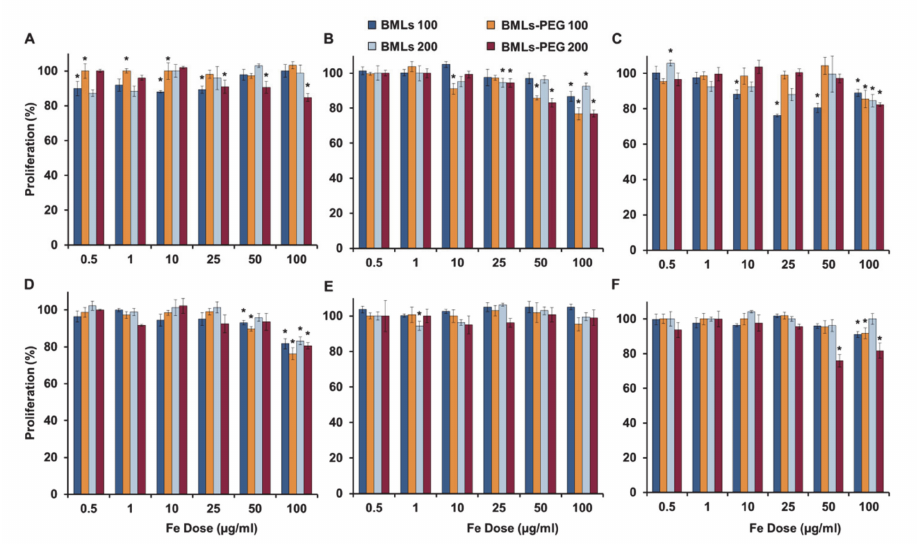
Figure 5. Cell proliferation assay of colon cell lines treated with BMLs and BMLs-PEG. The cell lines T84 ( A ), CCD18 ( B ), SW480 ( C ), HCT15 ( D ), HT29 ( E ) and MC38 ( F ) were exposed to increasing concentrations of Fe from 0.5 to 100 µ g / mL from BMLs and BMLs-PEG for 72 h. The graphs represent the percentages of proliferation of all the cell lines obtained using the SRB assay. Data represent the mean values ± SD of triplicate cultures. Statistically significant di ff erences with respect to untreated control ( p < 0.05) are represented with